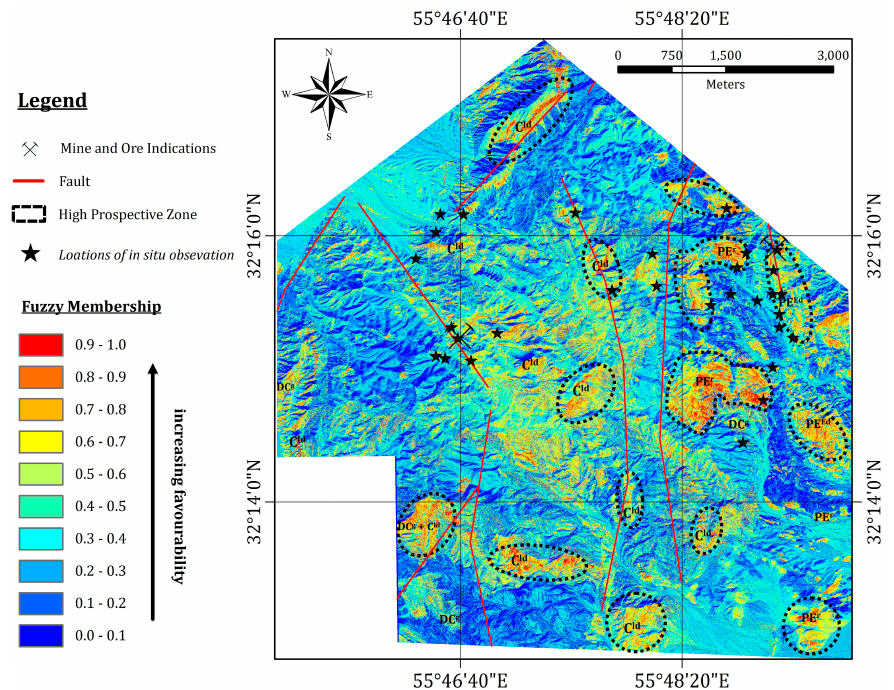
Figure 13. Mineral prospectivity map of the study area at local scale derived from WV-3 selected alteration thematic alteration thematic layers.